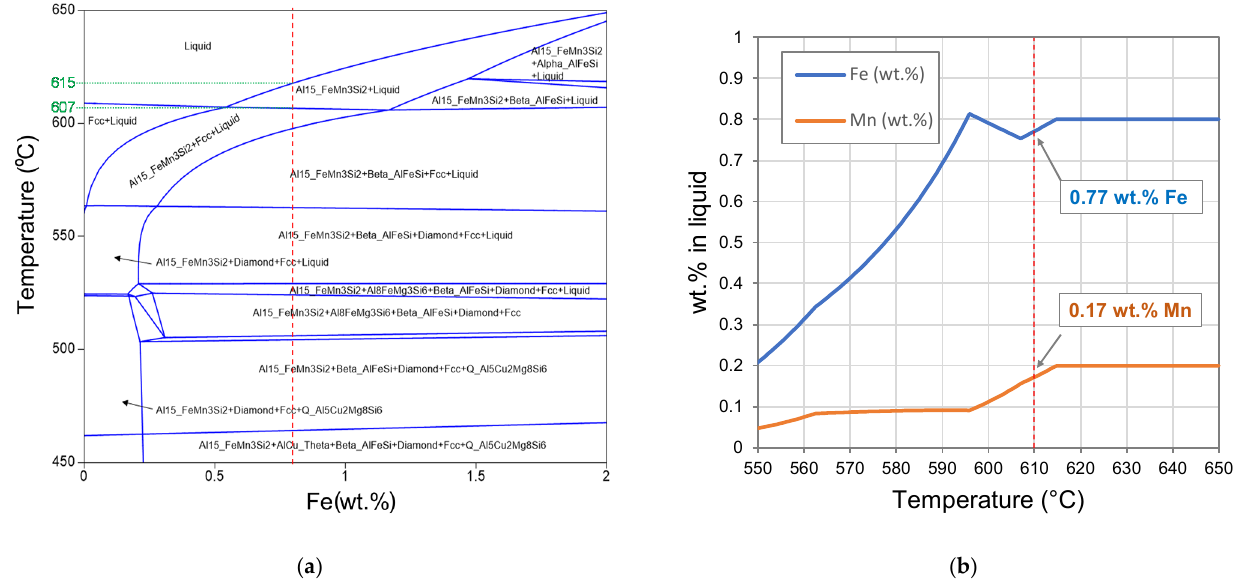
Figure 4. ( a ) Equilibrium phase diagram of the as-received Zorba cast fraction-xFe system, ( b ) Liquid composition of the as-received Zorba cast fraction alloy for the first trail. Table 3. Chemical composition of the as-received Zorba cast fraction before and after de-ironing by high-shear melt conditioning. Wt.% After HSMC and holding 30 min at 610 ◦